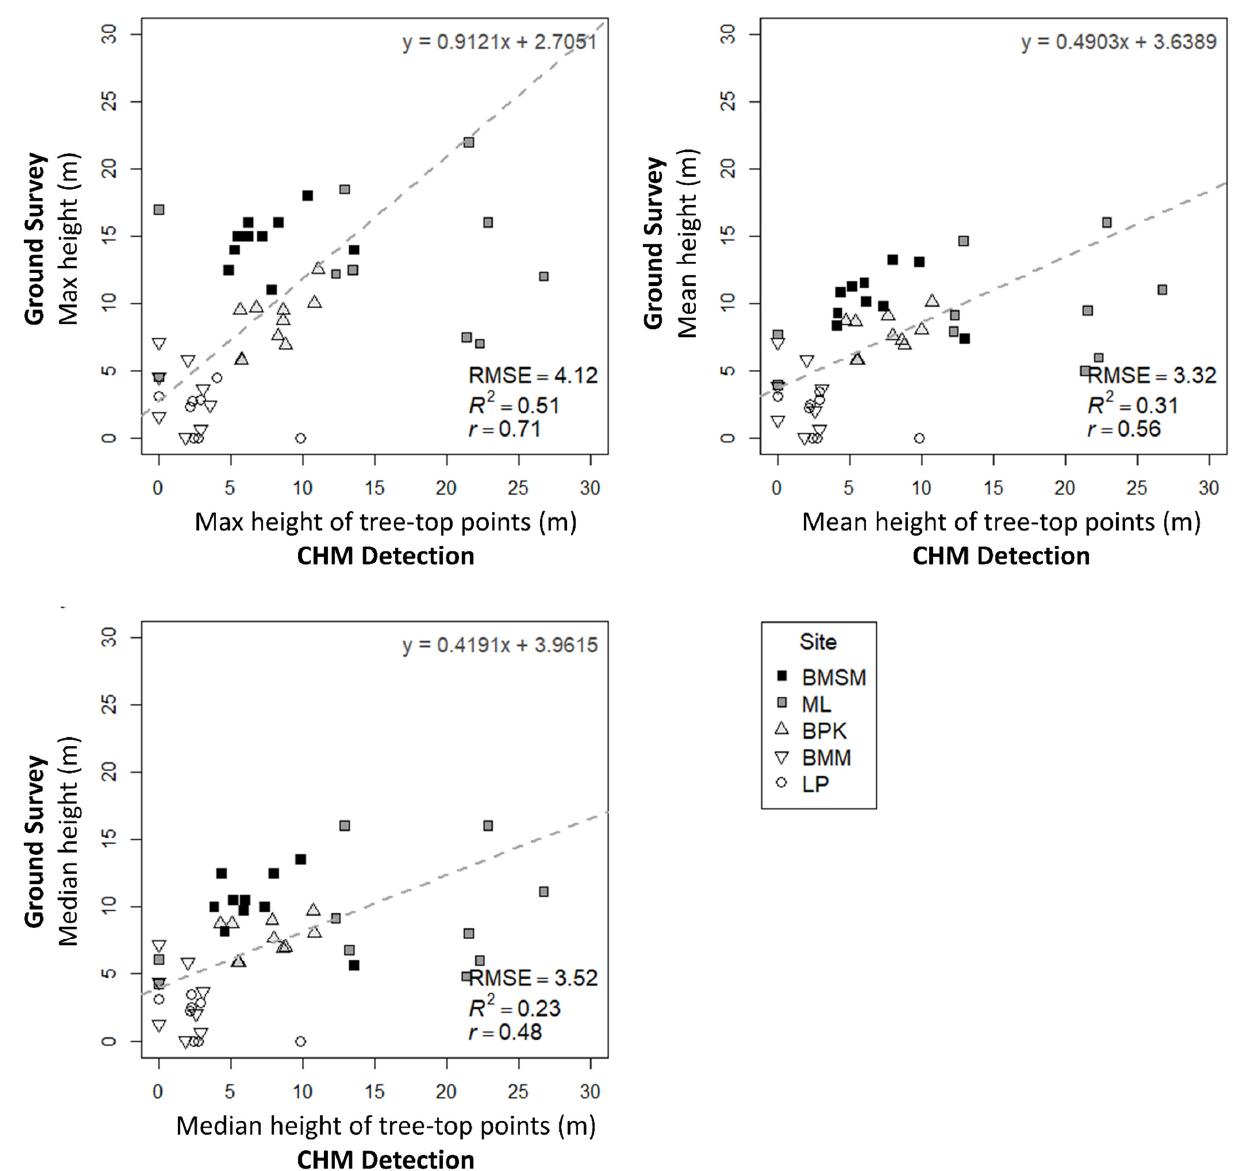
Figure 10. Scatter plots of tree height variables: ( Left ) Max height. ( Right ) Mean height. ( Lower ) Median height. CHM = Canopy-height model; RMSE = Root mean square error; r = Pearson’s correlation coefficient.